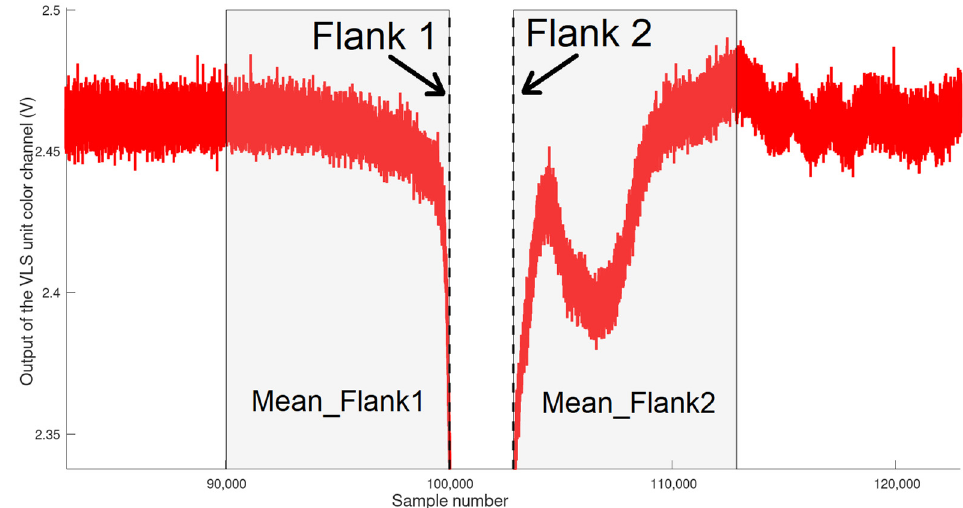
Figure 7. Zoomed-in view of the red channel of the VLS unit with the labeling for the flanks and the periods for the calculation of Mean_Flank1 and Mean_Flank2.